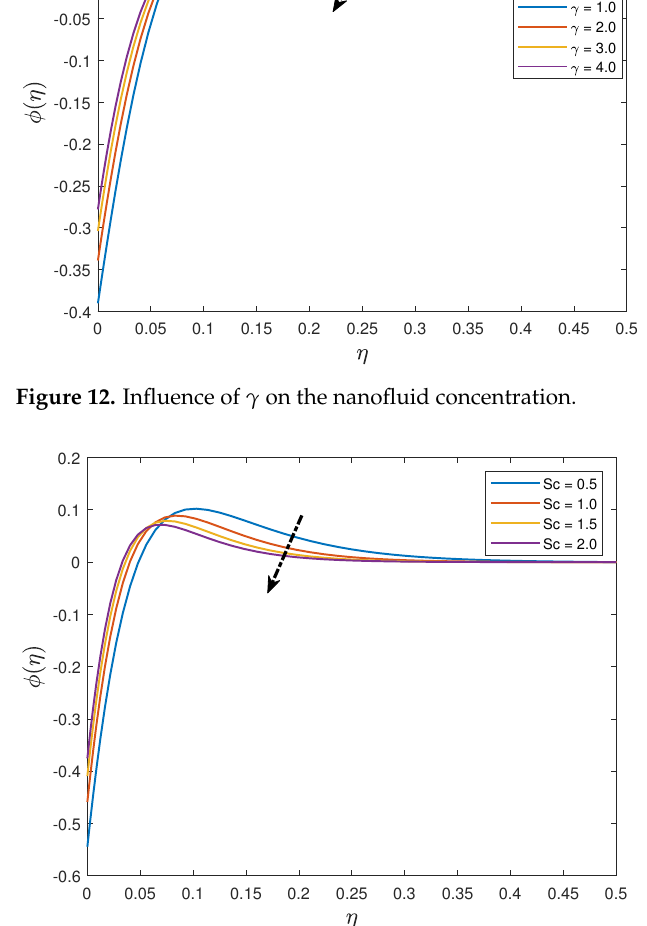
Figure 13. Influence of Sc on the nanofluid concentration.